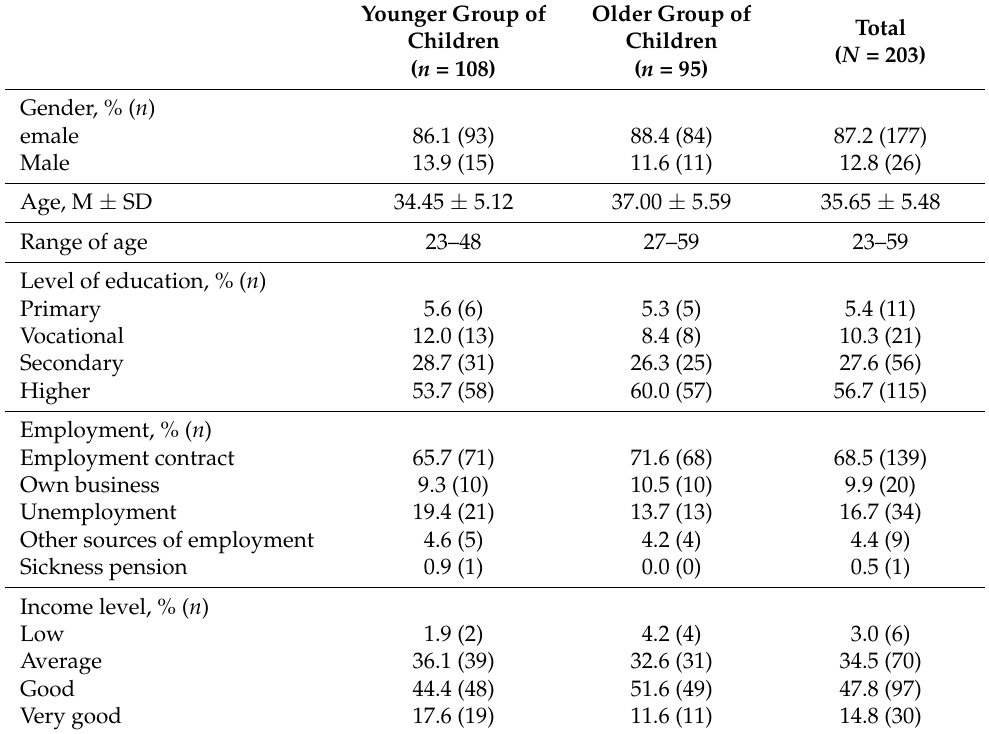
Table 1. Characteristic of the parent group.